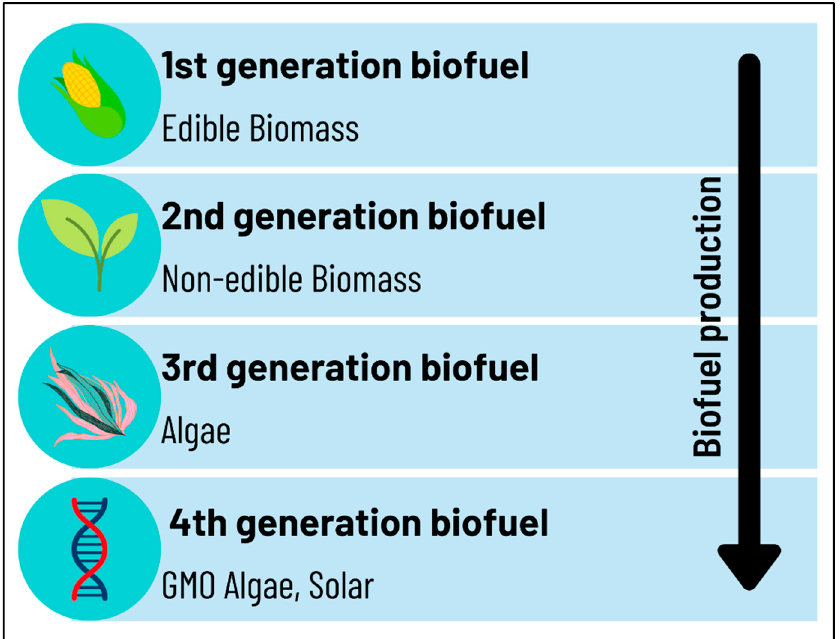
Figure 1. Generations of biodiesel advancement. Reprinted/adapted with permission from Abdullah, et al. [6], Elsevier 2019.